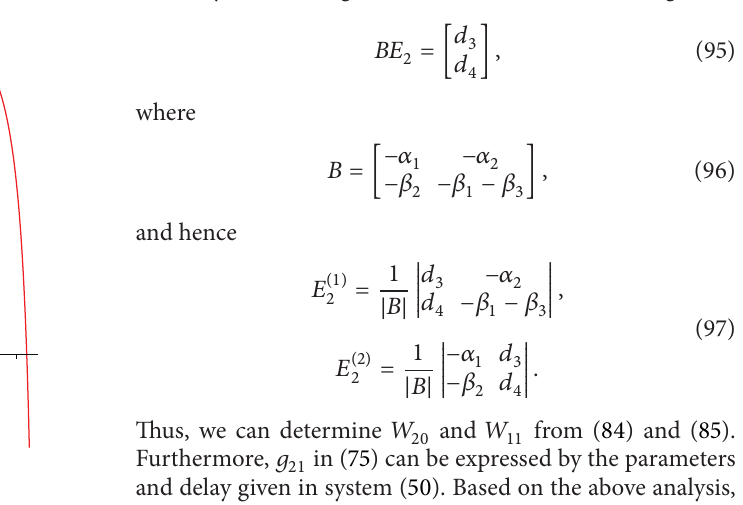
Figure 3: Graph of the function 𝑆 0 (𝜏)